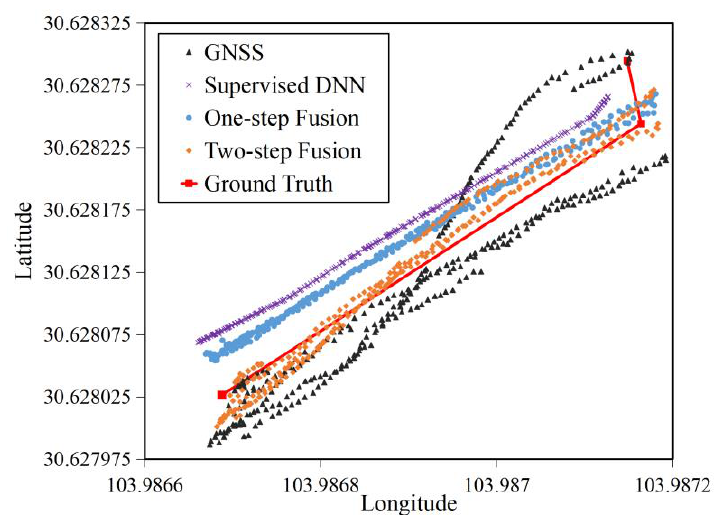
Figure 13. Location distributions when the image detection errors and GNSS measurement errors